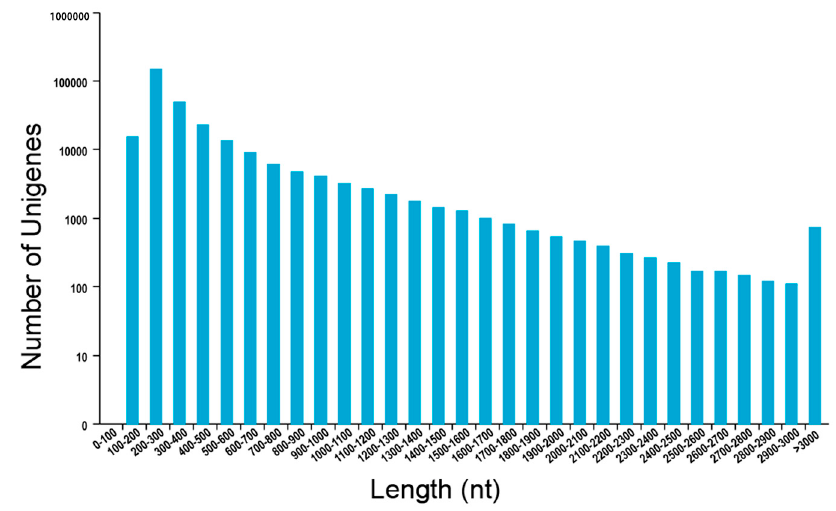
Table 1. Assembly statistics for Phelipanche aegyptiaca transcriptome.